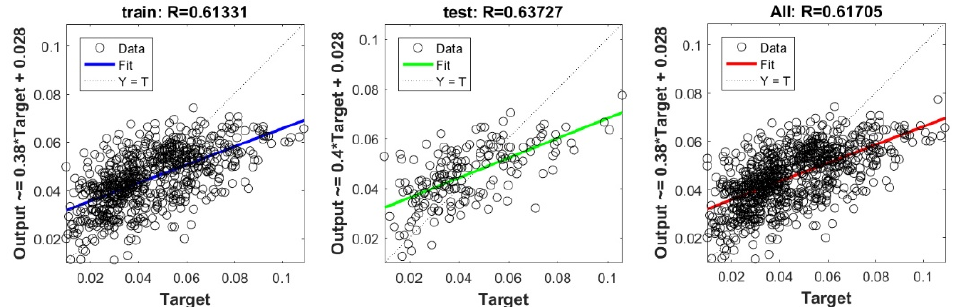
Figure A15. Scatter plots between target and output value by the GT-Lasso model.